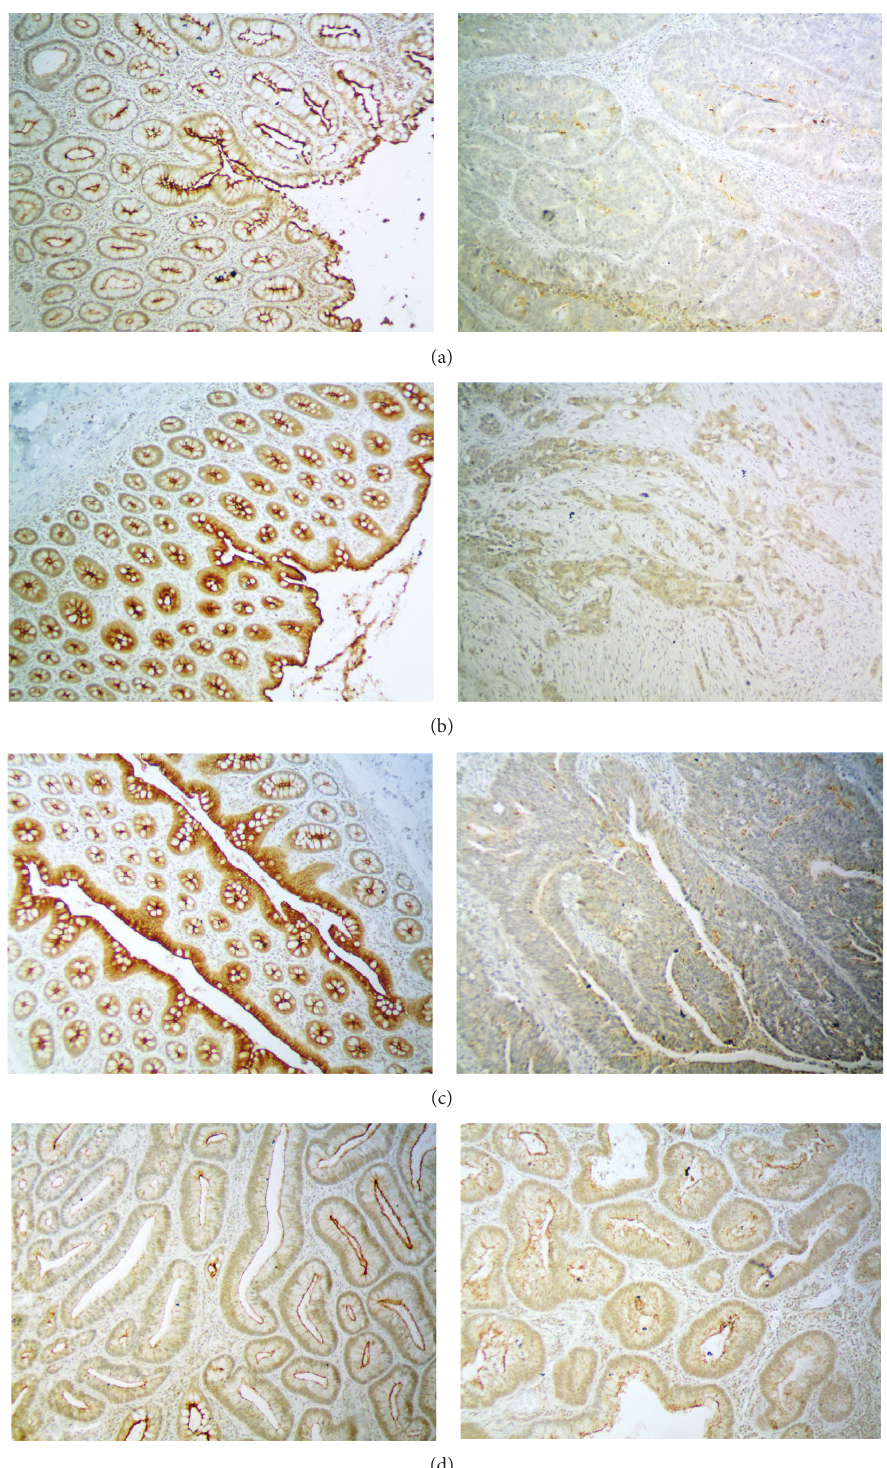
Figure 2: Immunohistochemical staining examples of mucin-like protocadherin in tissue samples. (a–c) Three examples of adenocarcinoma (AC) and matched normal colonic mucosa (NC). Two of the samples were classified as negative for membrane expression (a, b) and one as of low expression (c); (d) two examples of adenomas with moderate mucin-like protocadherin membrane expression; magnification ×